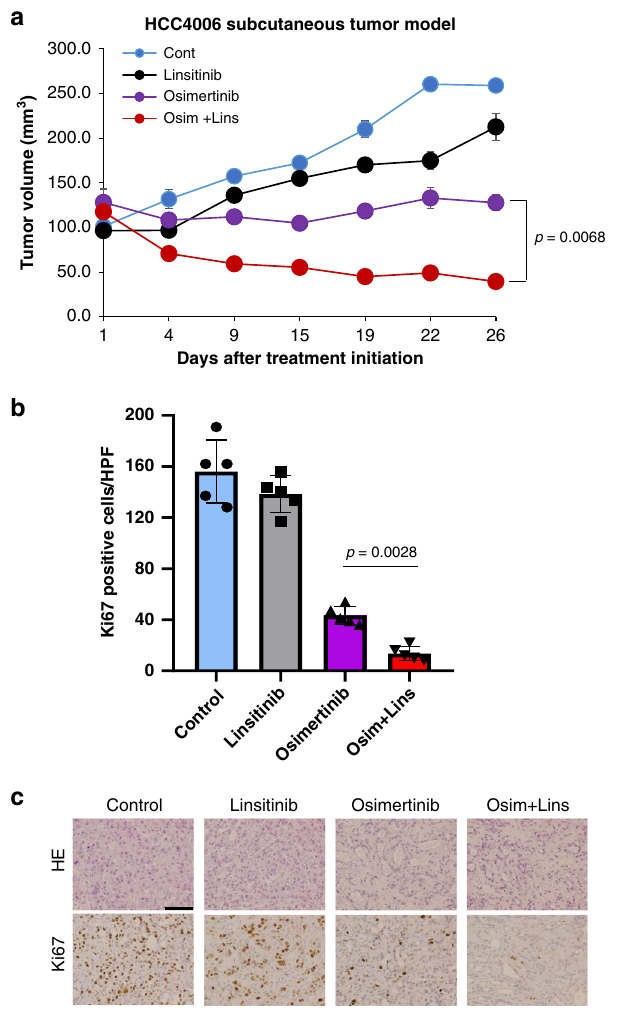
Fig. 6 Linsitinib with a suboptimal dose of osimertinib regresses AXL-low tumors in vivo. a HCC4006 cell line-derived xenograft (CDX) tumors were treated with vehicle (control: n = 4 mice), linsitinib 50mg/kg ( n = 4 mice), osimertinib 5mg/kg ( n = 5 mice), or linsitinib 50mg/kg plus osimertinib 5 mg/kg ( n = 5 mice), administered daily by oral gavage. Tumor volumes were measured over time from the start of treatment (mean±s.e.m.). p values are provided (two-sided Student ’ s t -tests). b Quanti fi cation of proliferating cells, as determined by their Ki-67-positive proliferation index (percentage of Ki- 67-positive cells) as described in “ Methods ” . Columns, mean of fi ve areas. Data are presented as mean±s.d. p values are provided (two-sided Student ’ s t -tests). HPF high power fi eld. c Representative images of HCC4006 xenografts for H&E staining and immunohistochemical staining with antibodies to human Ki-67. Bar, 100 μ